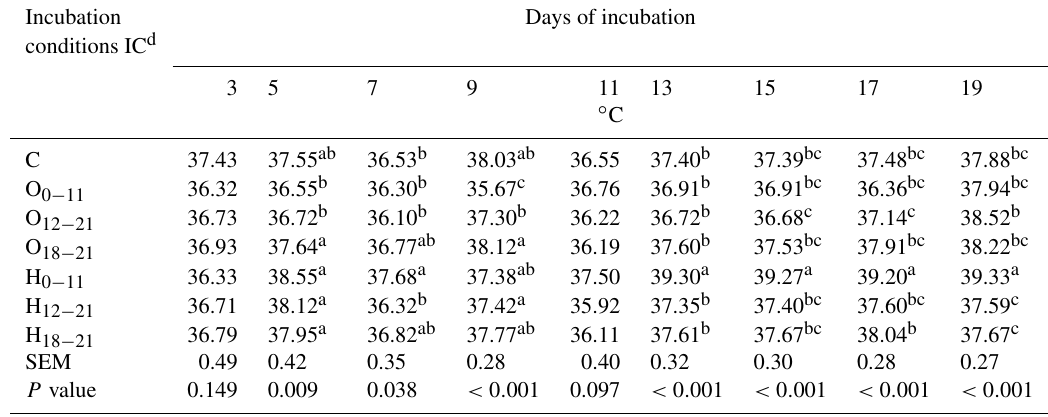
Table 2. Effects of incubation conditions (ICs) on eggshell temperature induced by hypoxia at high altitude in embryonated broiler eggs. Incubation Days of incubation conditions IC d